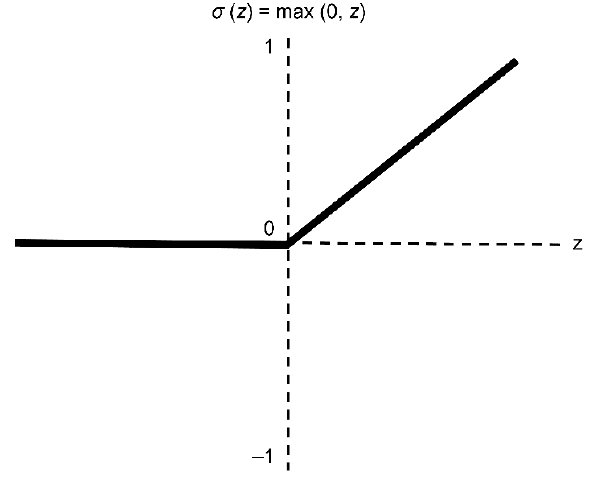
Figure 1. ReLU activation function.